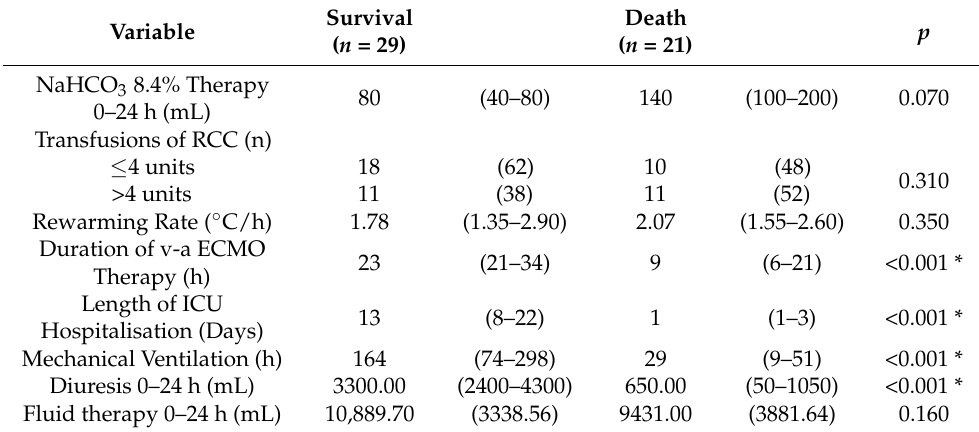
Table 3. Distribution of the analysed clinical parameters in the survivors and those that